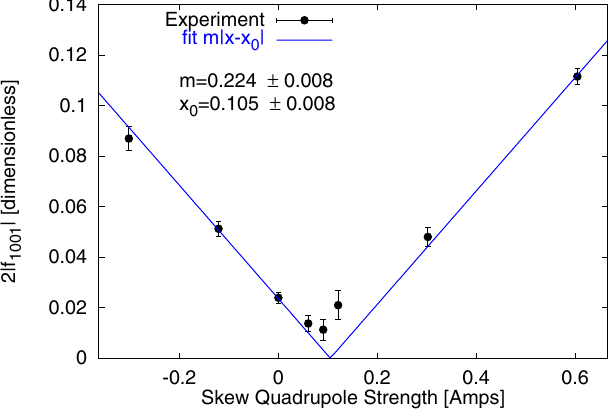
FIG. 11. (Color) Coupling resonance term versus the strength of skew quadrupoles.